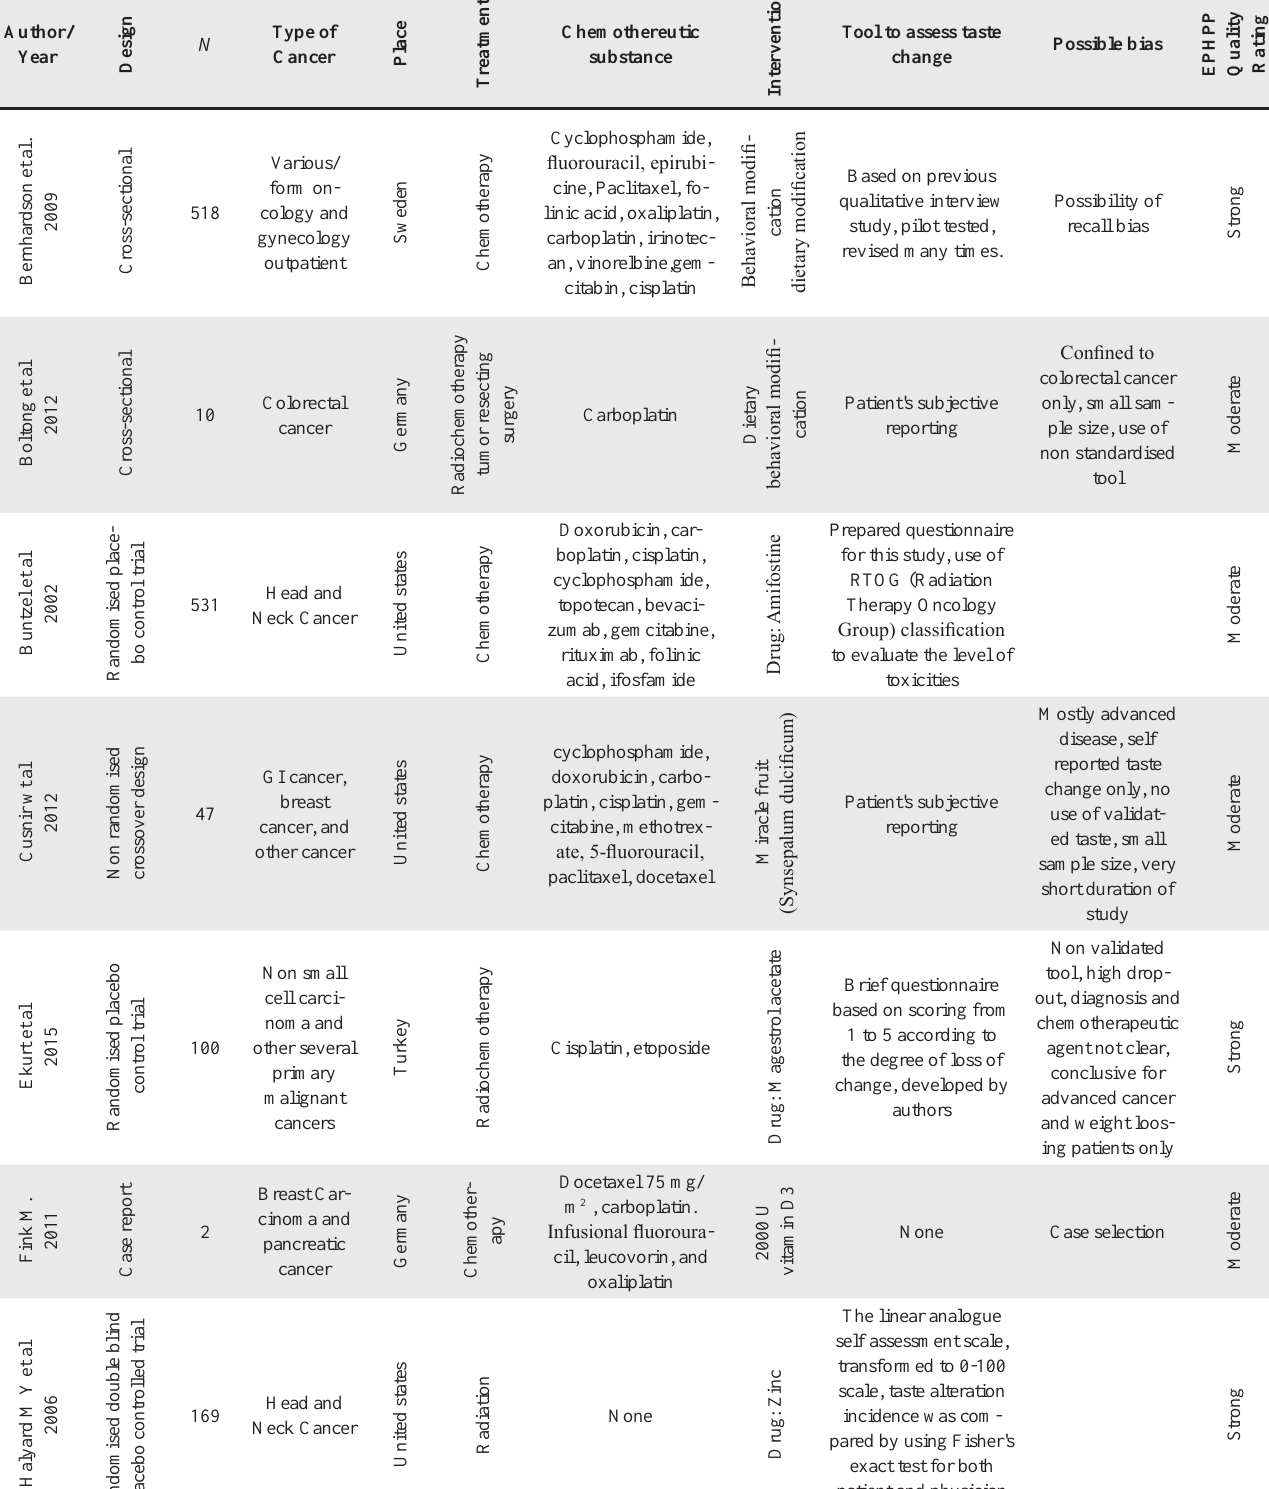
Table 1 : Summary, characteristics and findings of studies included in the review (Table continued to next